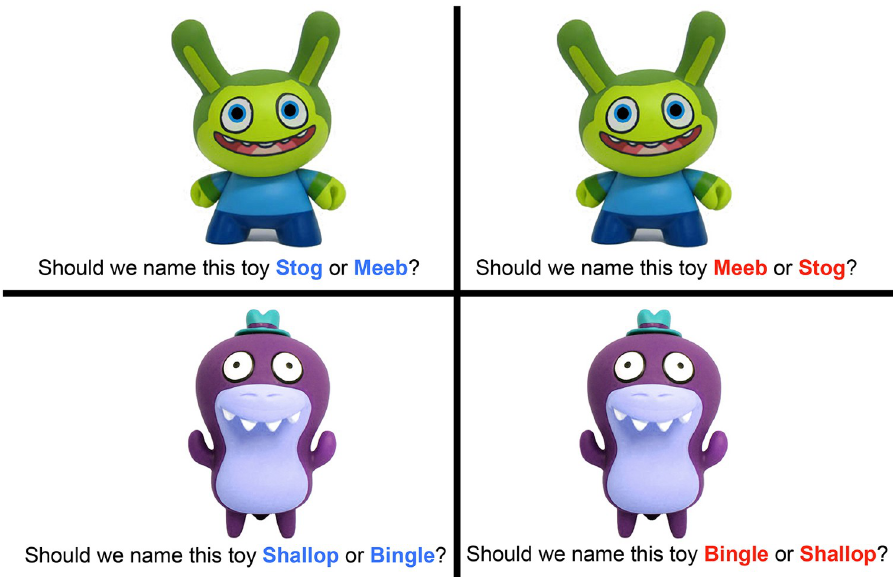
Fig 4. Set up for Experiment 2. Examples of novel toy pictures used in the experiment, along with the verbal prompt. Children were asked to name a series of 20 toys (e.g., choices in the blue on the left). Later they were shown the same toys and asked to name them again in the opposite order (e.g., choices in the red on the right). Names varied in syllable length.